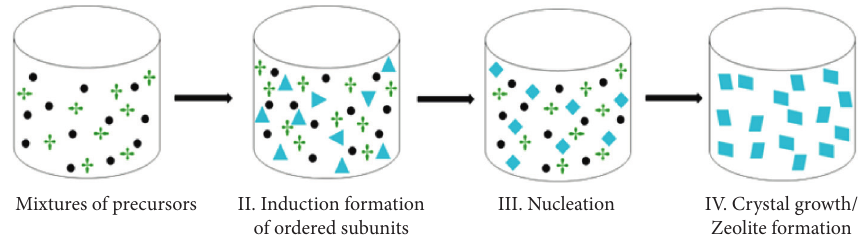
Figure 2: Steps in zeolite synthesis adopted from Omisanya et al.